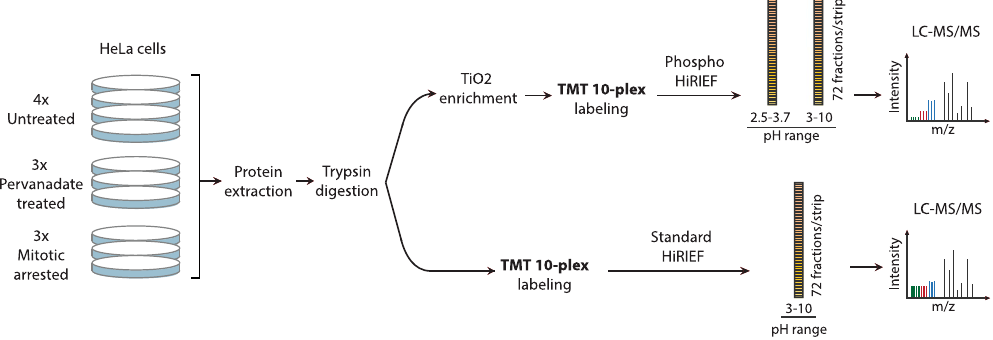
Figure 1. Experimental workflow applied to perform HiRIEF-based phosphoproteomics analysis. Protein extracts from HeLa cells untreated (4 replicates), pervanadate treated or arrested in mitosis (3 replicates each) were digested to peptides with trypsin. For Phospho HiRIEF analysis, samples were enriched for phosphorylated peptides with titanium dioxide (TiO 2 ), labeled with Tandem Mass Tags (TMT) and pooled. The pooled sample was split in two and fractionated by HiRIEF using immobilized pH gradient (IPG) strips with pH range 2.5–3.7 (ultra-acidic strip) and 3–10 (wide-range), prior to LC-MS analysis. For standard